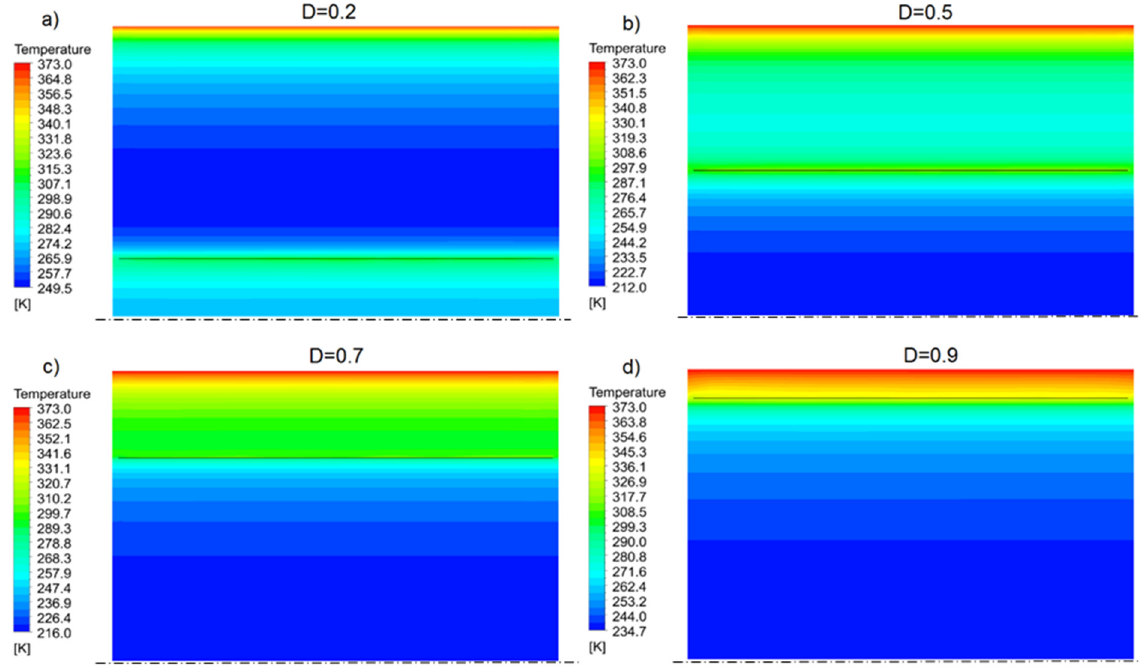
Figure 10. Schemes follow the same formatting. Temperature profiles in the symmetry plane for several dimensionless insert diameters D and the same number Re = 13,500. ( a ) D = 0.2, ( b ) D = 0.5, ( c ) D = 0.7, ( d ) D =